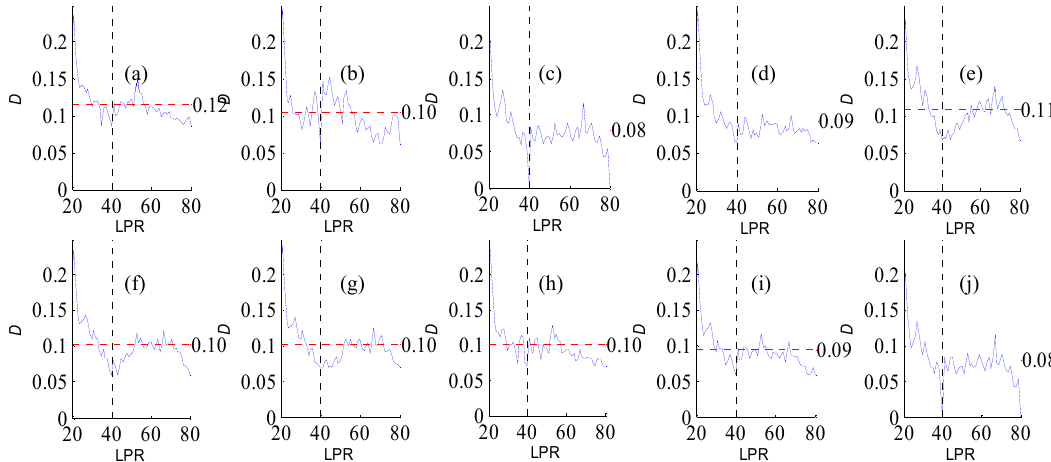
Figure A31. Variation of flow regime alteration degree (D) measured by the RVA with change in the length of pre-impact flow time series (LPR) under a periodicity of 40 years. ( a – j ) correspond to pre-impact flow time series length = 29, 34, 40, 46, 51, 57, 63, 69, 74, and 80 years, respectively. The abscissa value for the vertical dotted line is 40. The ordinate value for the horizontal dotted line is the mean degree of flow regime alteration in each subfigure.